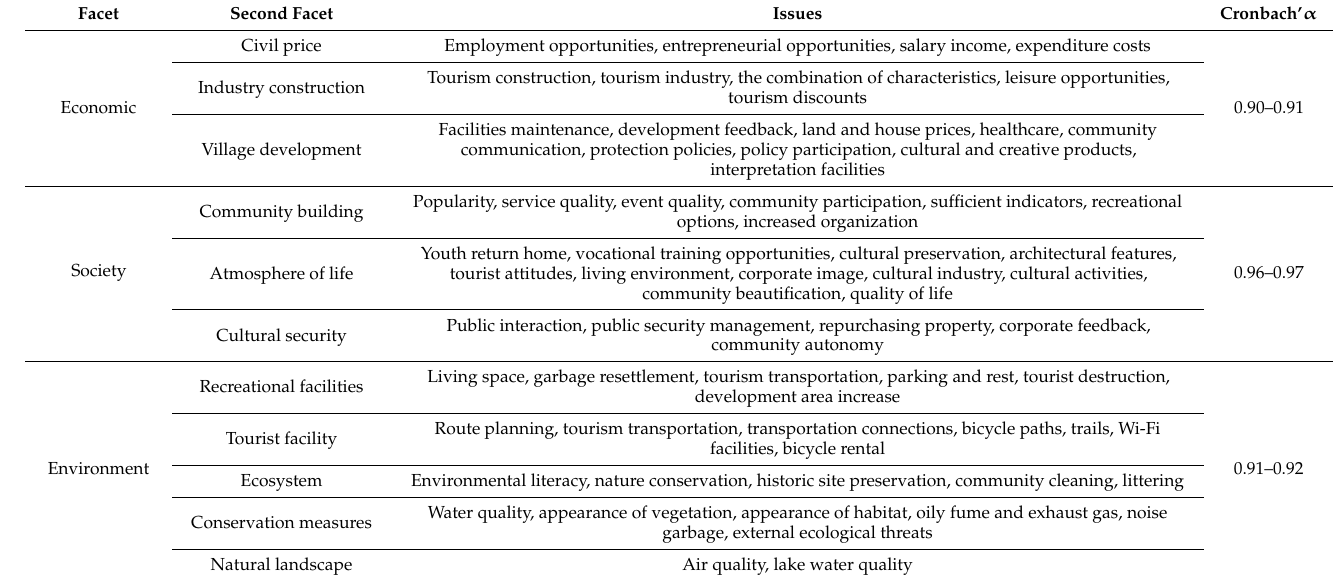
Table 1. Analysis of factors in the perception of impacts on tourism.